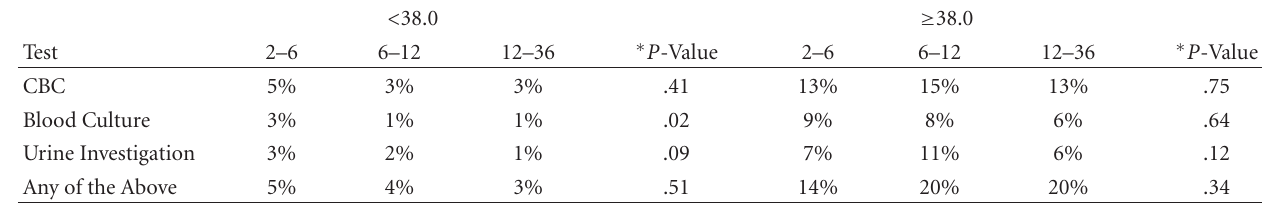
Table 3: Laboratory evaluation of 2–36-month-old patients with acute otitis media stratified by temperature and age in months.